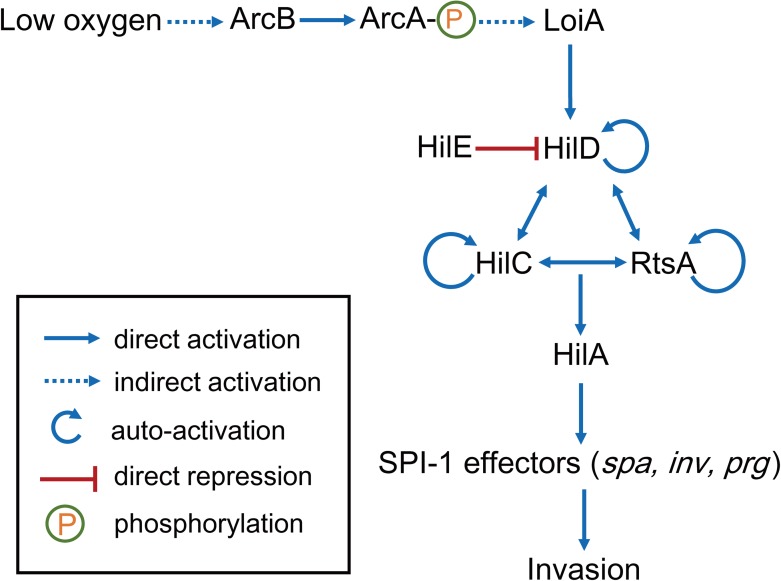
Model of the LoiA regulatory network in S. Typhimurium invasion.Under low O2 concentrations, the phosphorylated ArcA after sensing of low O2 signal by ArcB can indirectly activate loiA gene transcription, LoiA can then activate SPI-1 T3SS through directly activating HilD, thus promoting epithelial cell invasion.